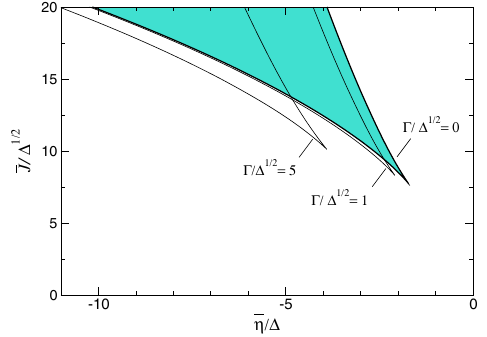
FIG. 9. Phase diagram for an excitatory population with heterogeneous currents and synaptic weights obtained using the FREs